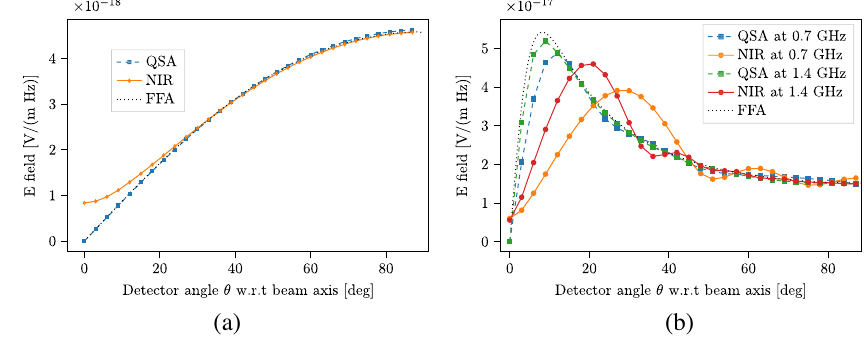
FIG. 2. (a) Comparison of normal incident radiation (NIR), quasispherical approximation (QSA) and far field approximation (FFA) for β ¼ 0 . 3 for target radius b ¼ 0 . 4 m, monitor distance R ¼ 0 . 4 m and frequency ¼ 0 . 7 GHz. (b) Comparison of NIR, QSA and FFA